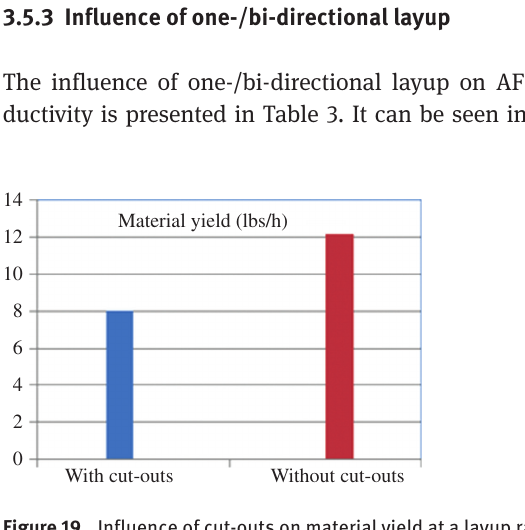
Figure 19 Influence of cut-outs on material yield at a layup rate of 18 m/min.